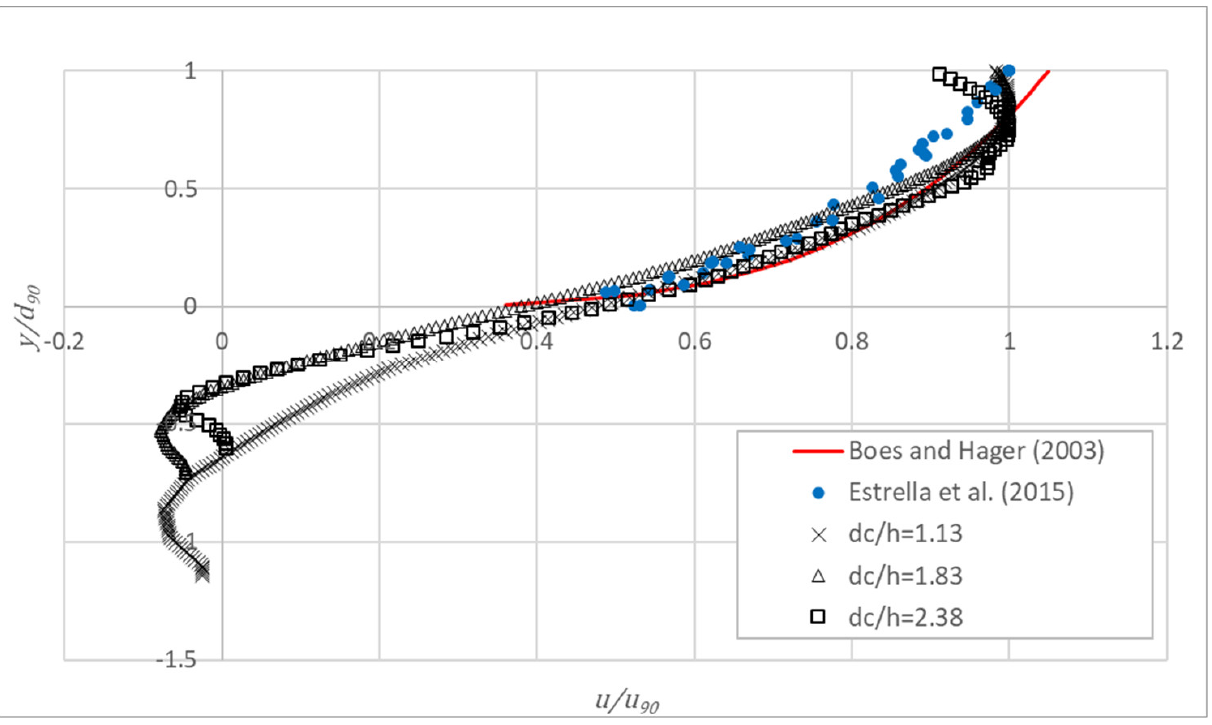
Figure 18. Dimensionless longitudinal velocity profile at L / L t = 0.49 along the normal to the pseudo − bottom from the internal edge of the step, for 400 fps and for 1.13 ≤ d c / h ≤ 2.38. Comparison with the results by Boess and Hager [13] and Estrella et al. [17].